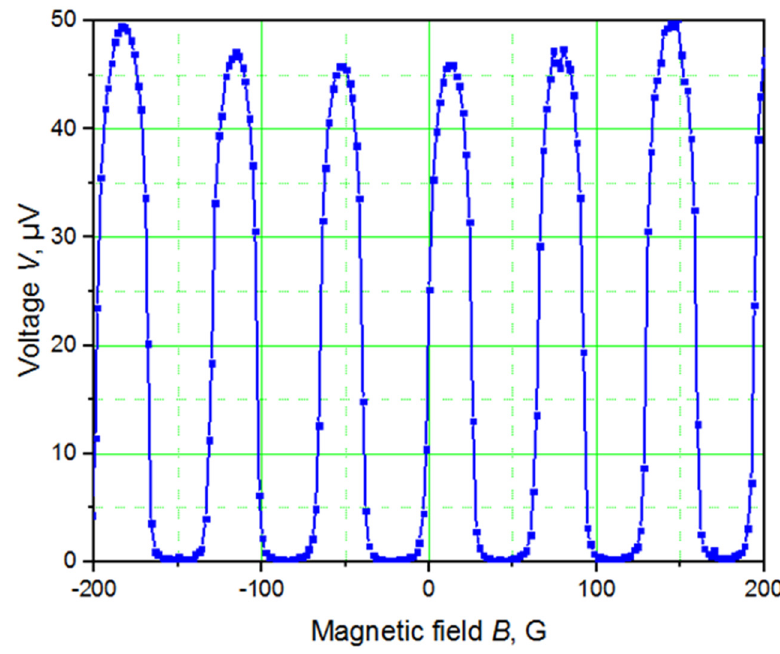
Figure 7. V(B) curve of the planar nanoSQUID with NbN-TiN-NbN nJJs measured with a bias cur- Figure 7. V ( B ) curve of the planar nanoSQUID with NbN-TiN-NbN nJJs measured with a bias current rent of 39 µA at 4.2 K. of 39 µ A at 4.2